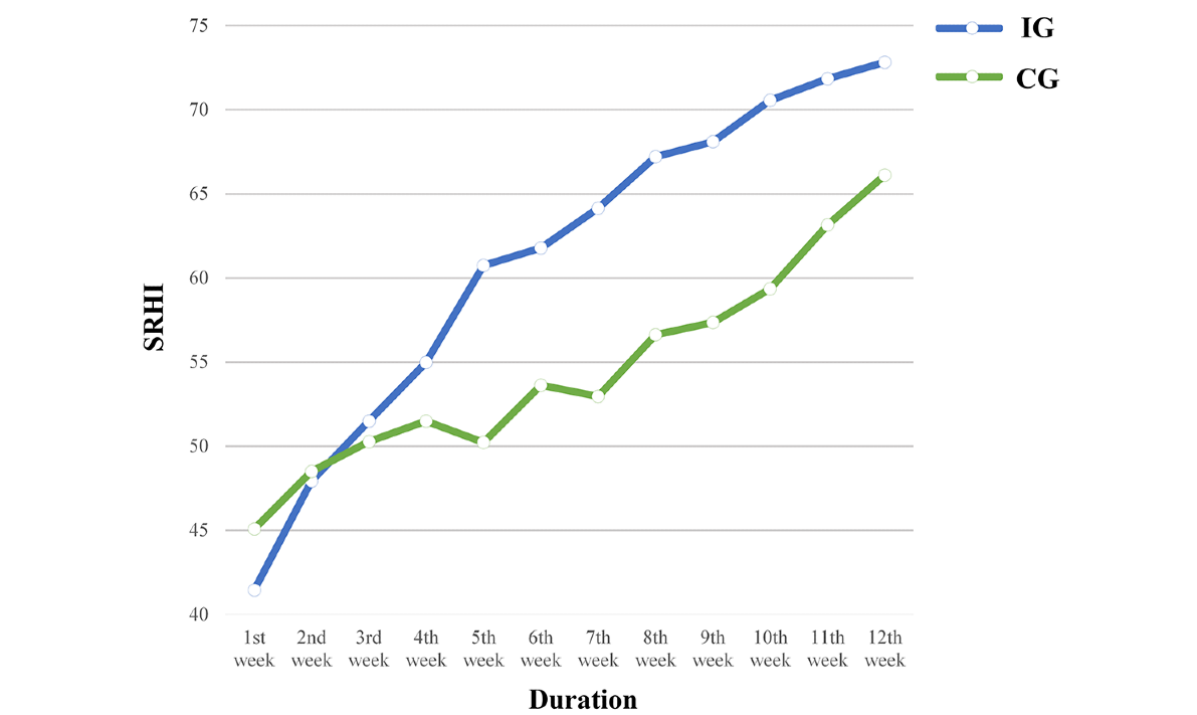
Figure 3. Plots of Self-Report Habit Index (SRHI) automaticity